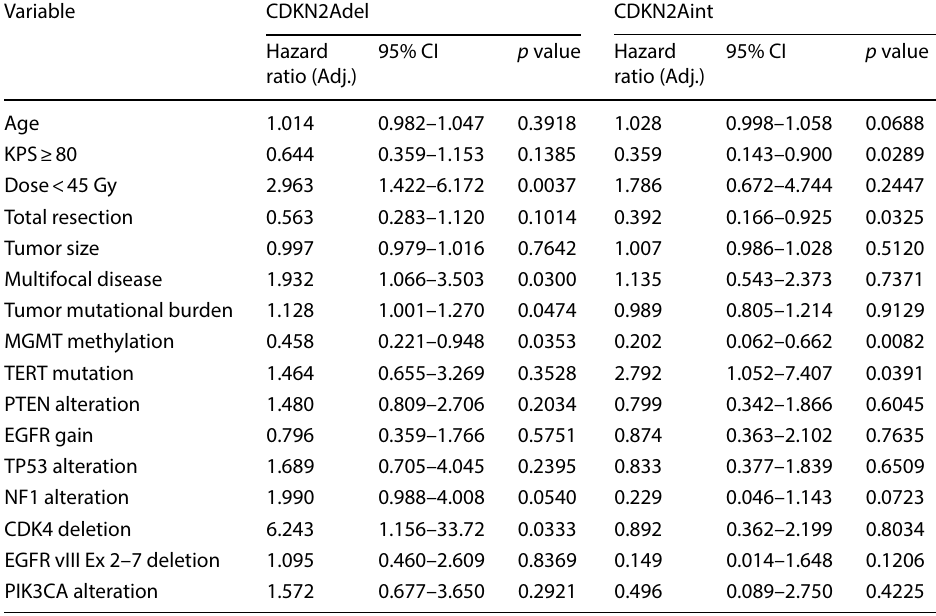
Table 4 Multivariable analysis of impact of patient characteristics, treatments, and tumor genetics on OS in